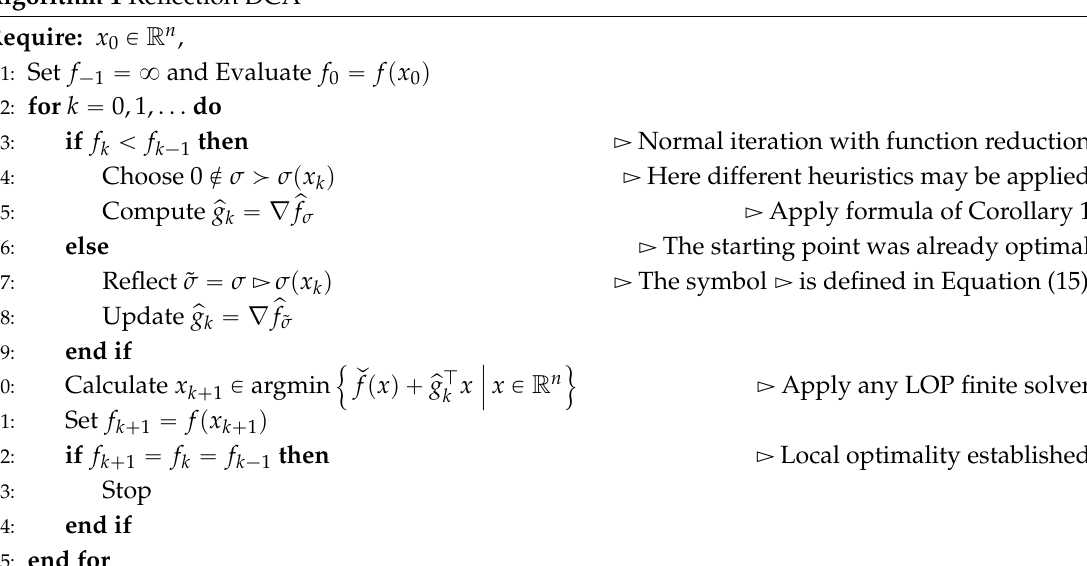
Algorithm 1 Reflection